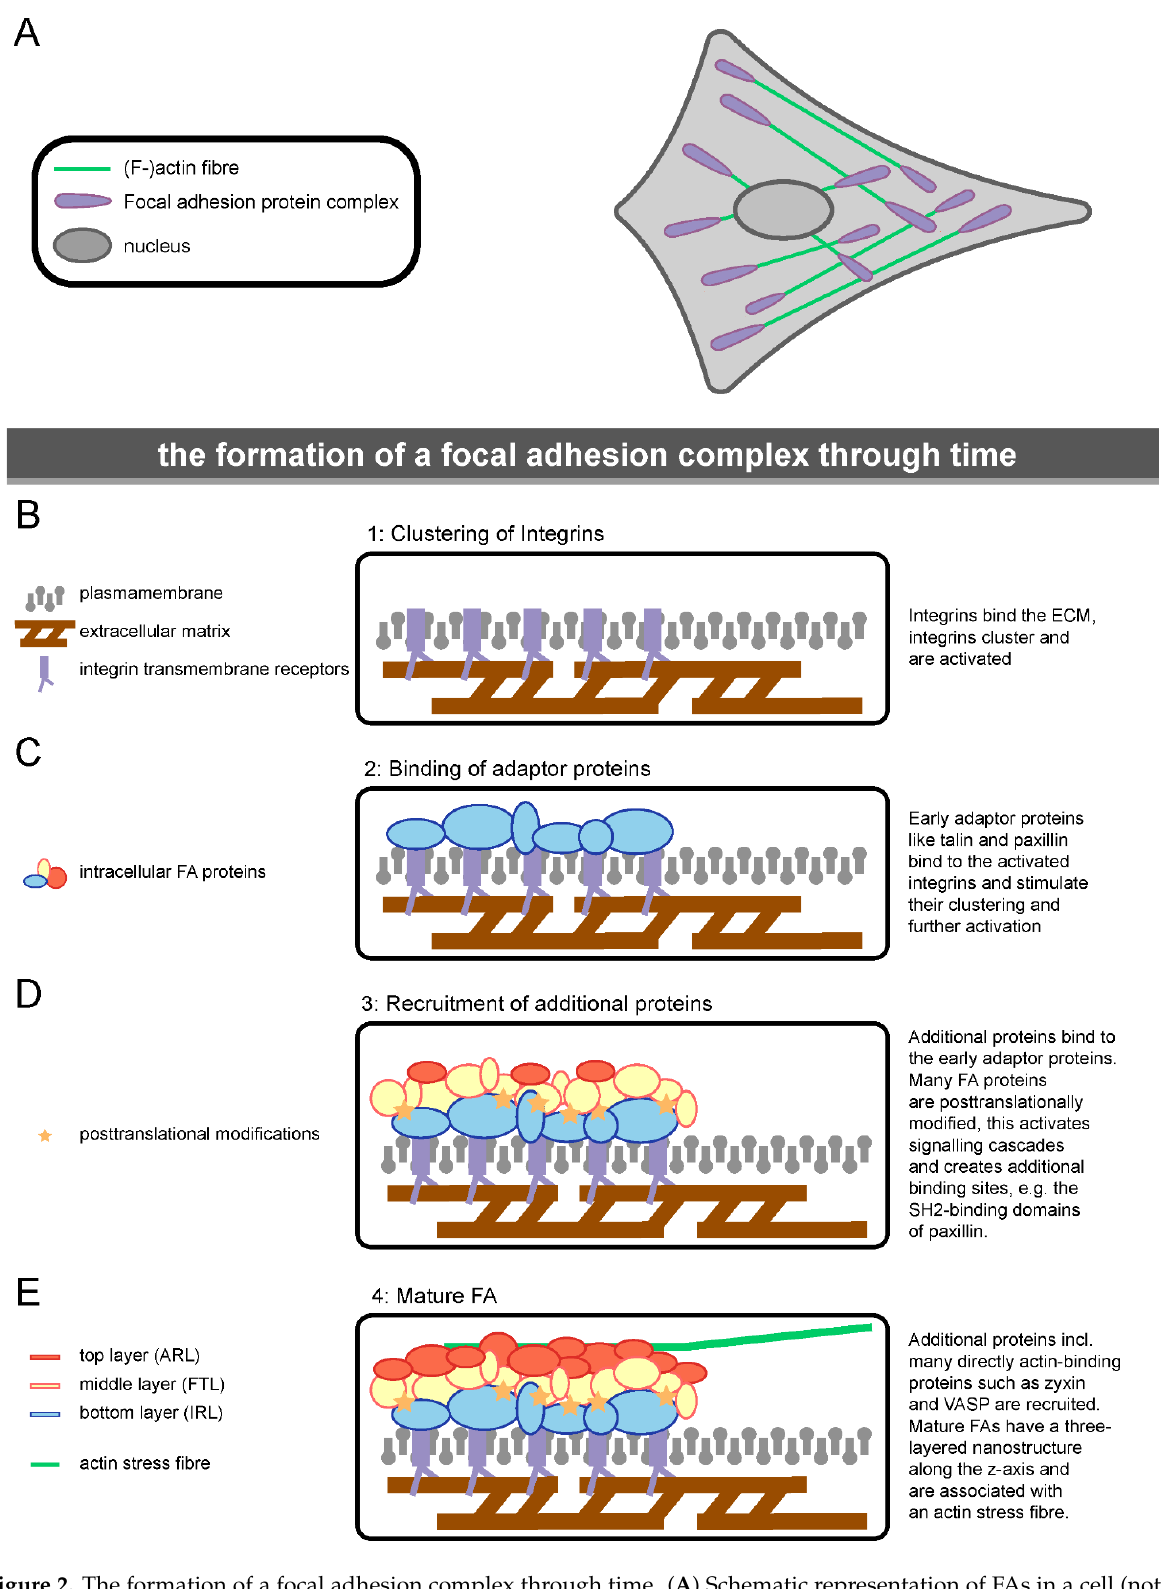
Figure 2. The formation of a focal adhesion complex through time. ( A ) Schematic representation of FAs in a cell (not to scale). ( B – E ) Simplified overview of the main steps involved in the formation of a focal adhesion complex. Steps shown in chronological order, from the initial clustering of integrin receptors ( A ) to the eventual formation of a mature three-layered focal adhesion with associated F-actin stress fibre ( D ).